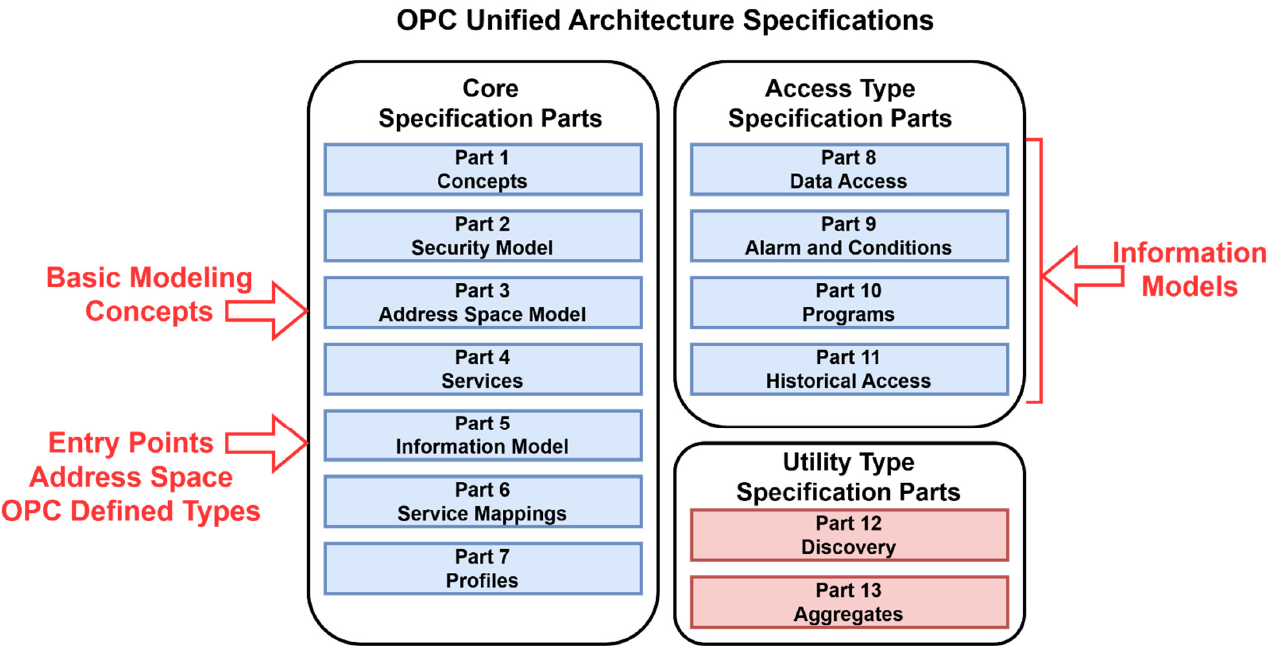
Figure 5. OPC unified architecture specifications.